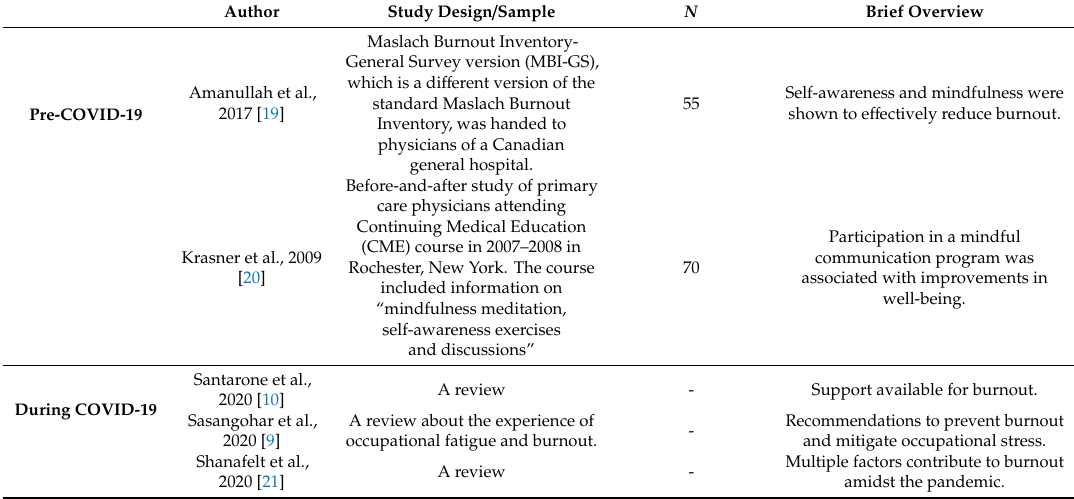
Table 4. Methodological characteristics and the main results for reviews on support / recommendations for physician burnout before and after